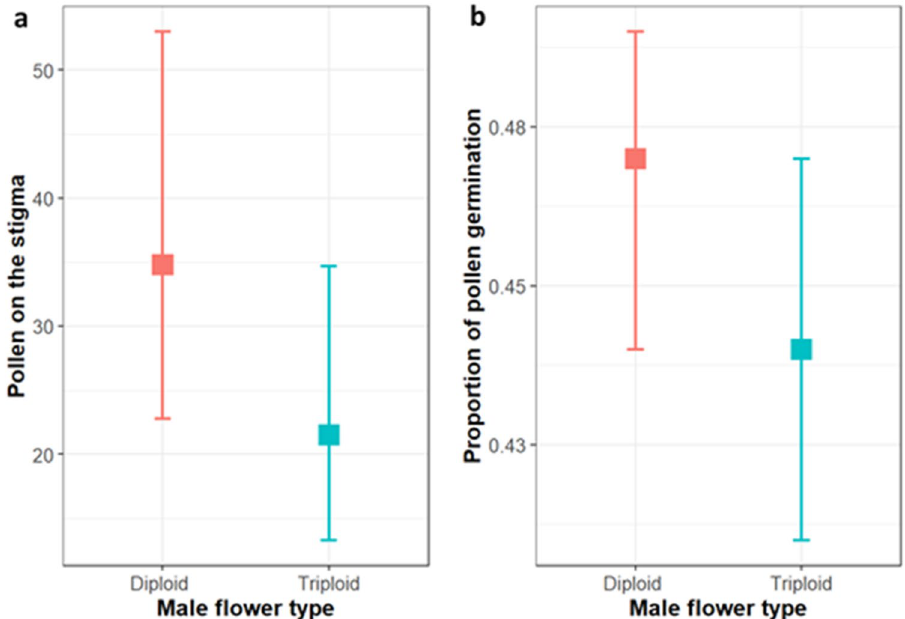
Figure 4. Number of pollen grains (a) on stigma and (b) proportion of pollen germination on stigma in triploid female flower followed by a honey bee visit after movement from diploid (n = 34) or triploid (n = 28) male flowers. Estimated means (square mark) and 95% confidential intervals are back-transformed from the logit